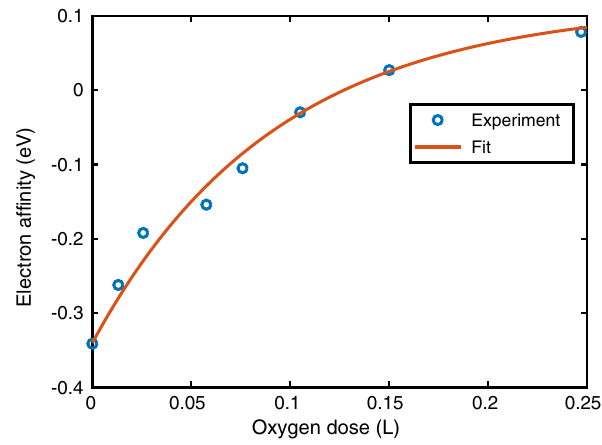
FIG. 6. The evolution of electron affinity of GaAsP during degradation process under oxygen enriched environment ( 10 − 10 Torr) with photon energy 2.33 eV (532 nm) in the experiment [25]. The fitting line from Eq. (30) is presented.